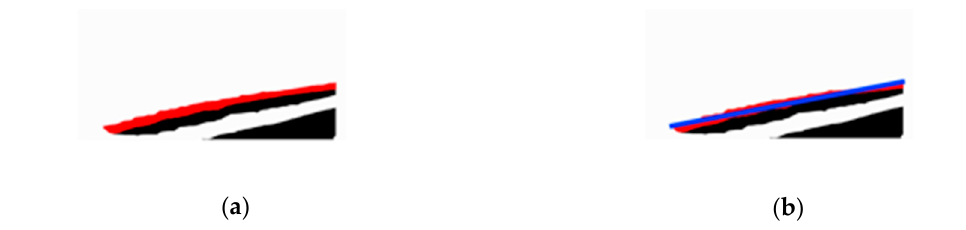
Figure 9. The result of fitting the upper contour of H b to a line: ( a ) the upper contour of H b (red line), ( b ) the fitted line (blue line). Algorithm 2. Computing the Position of Occluded People via Shadows Input: a represents which side of the user their shadow is located in, h f is the position of the head joint of H f in the RGB image, R is the search region, C is the binary image obtained by background subtraction.